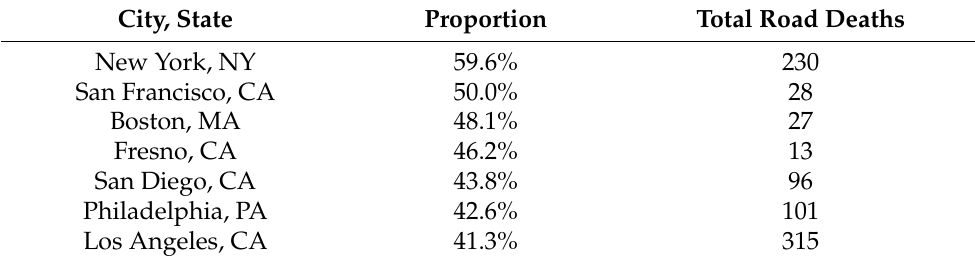
Table 2. Proportion of pedestrian deaths from total road deaths in selected US cities—2016